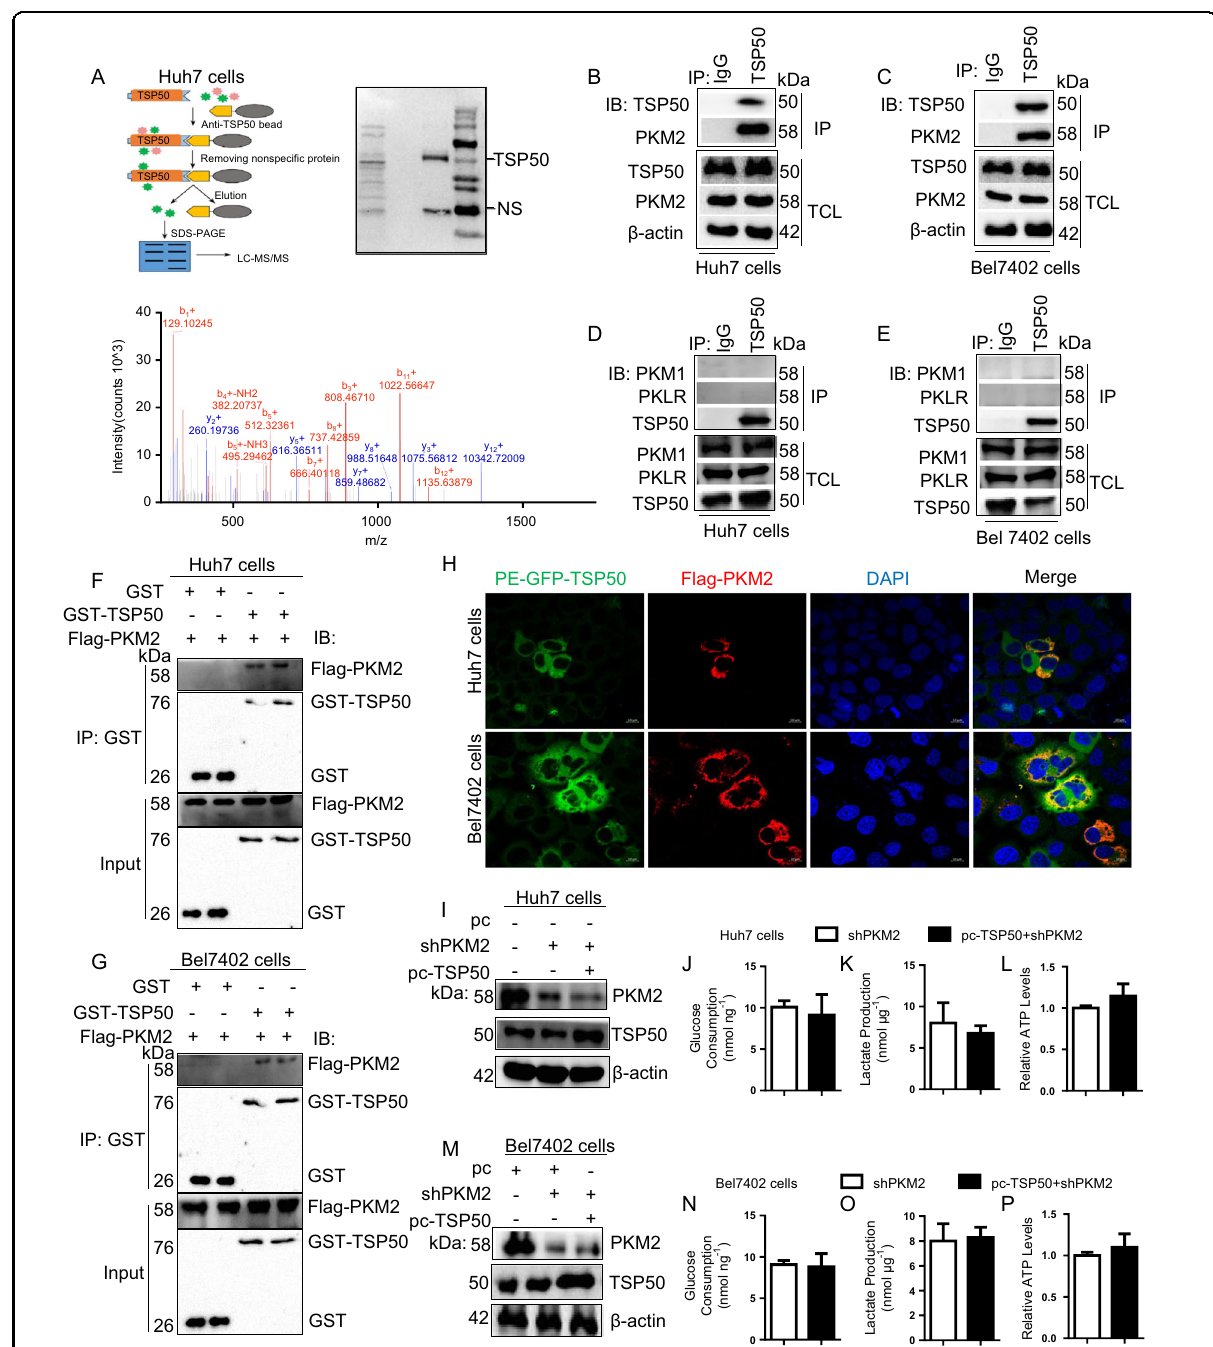
Fig. 4 TSP50 binds with PKM2 and depends on PKM2 for its metabolic effects. A Identi fi cation of proteins binding to endogenous TSP50 by LC- MS/MS in Huh7 cells. Candidate binding proteins to TSP50 were obtained after non-speci fi c proteins were removed. B , C Huh7 and Bel7402